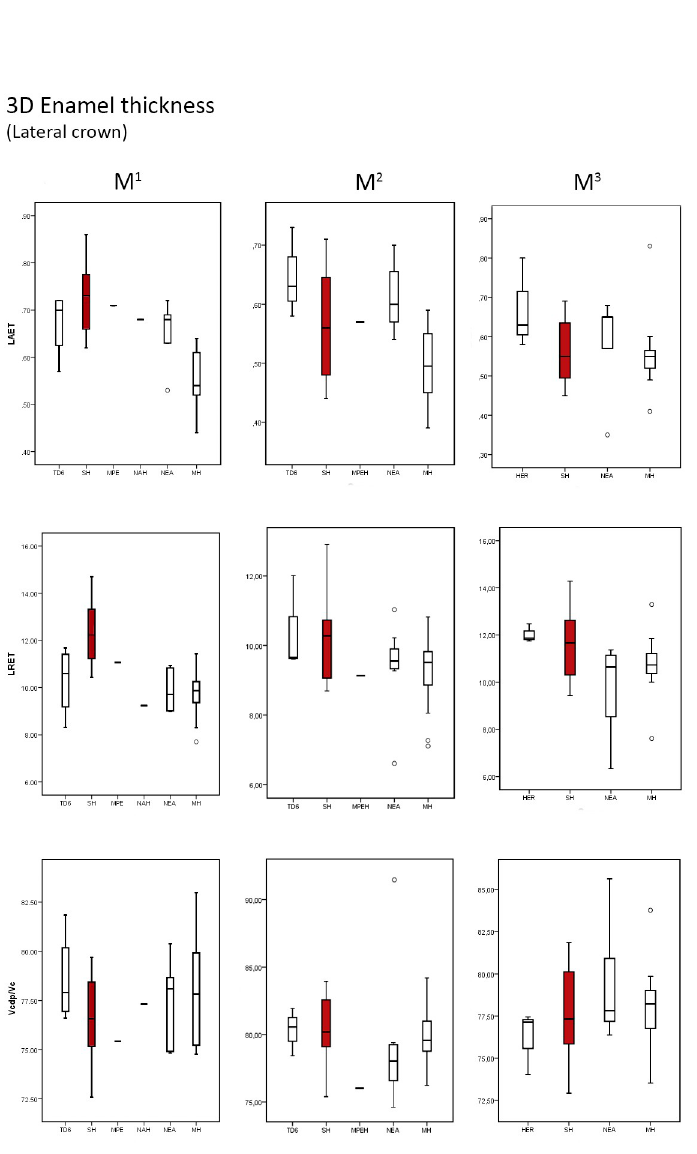
Fig 7. Box plots of the 3D, lateral enamel, values. 3D values depicting the lateral average enamel thickness (3D LAET), lateral relative enamel thickness (3D LRET) and the percentage of dentine and pulp in the lateral aspect of the crown (LVcdp/LVc), in the maxillary molars of the SH and the comparative